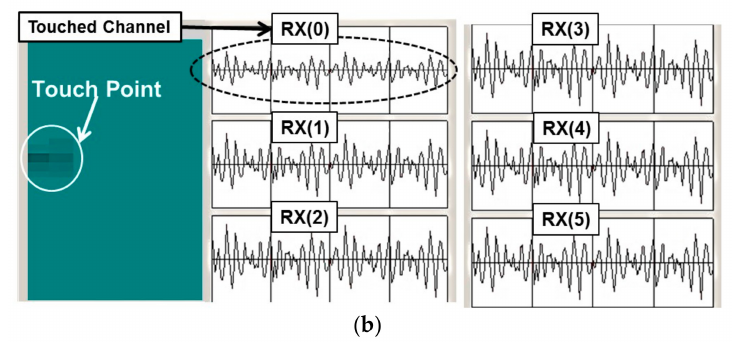
Figure 27. ( a ) No touch and ( b ) touch image in the software program.